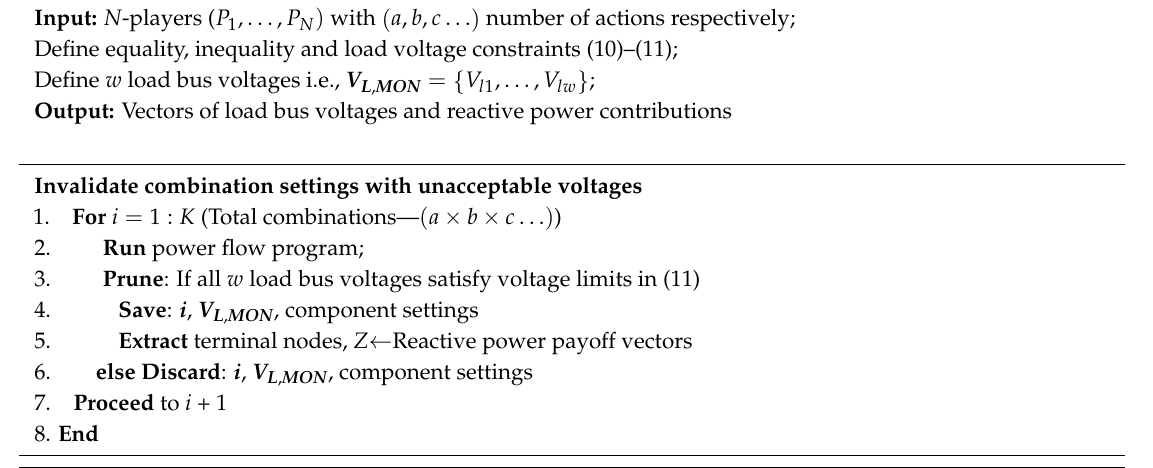
Algorithm 1 Prior data